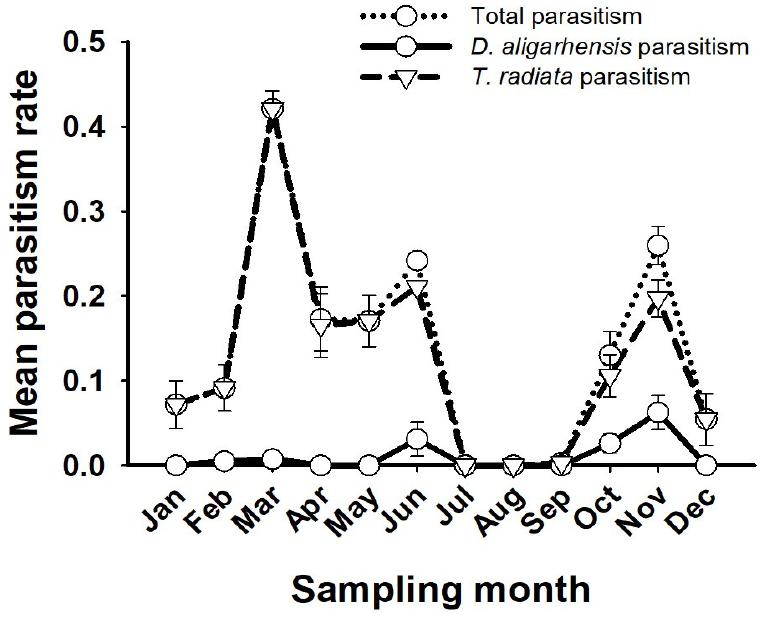
Figure 3. Mean ( ± SE) total and species-specific parasitism rates of Diaphorina citri by Tamarixia radiata and Diaphorencyrtus aligarhensis at study sites in southern California from January 2016 through December 2017 (pooled across study years, climate types, and host plants).